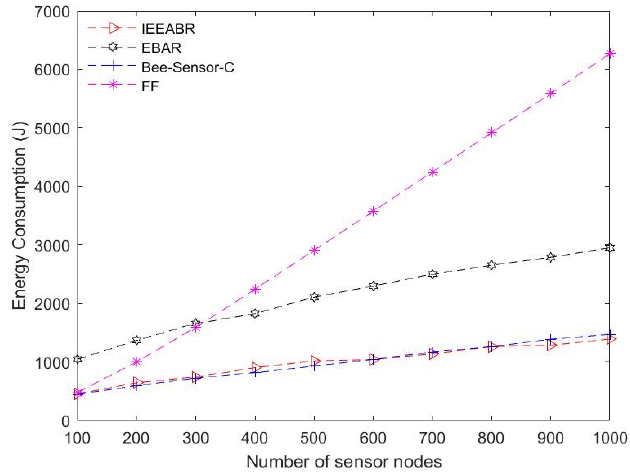
Figure 17. Comparison based average energy consumption.